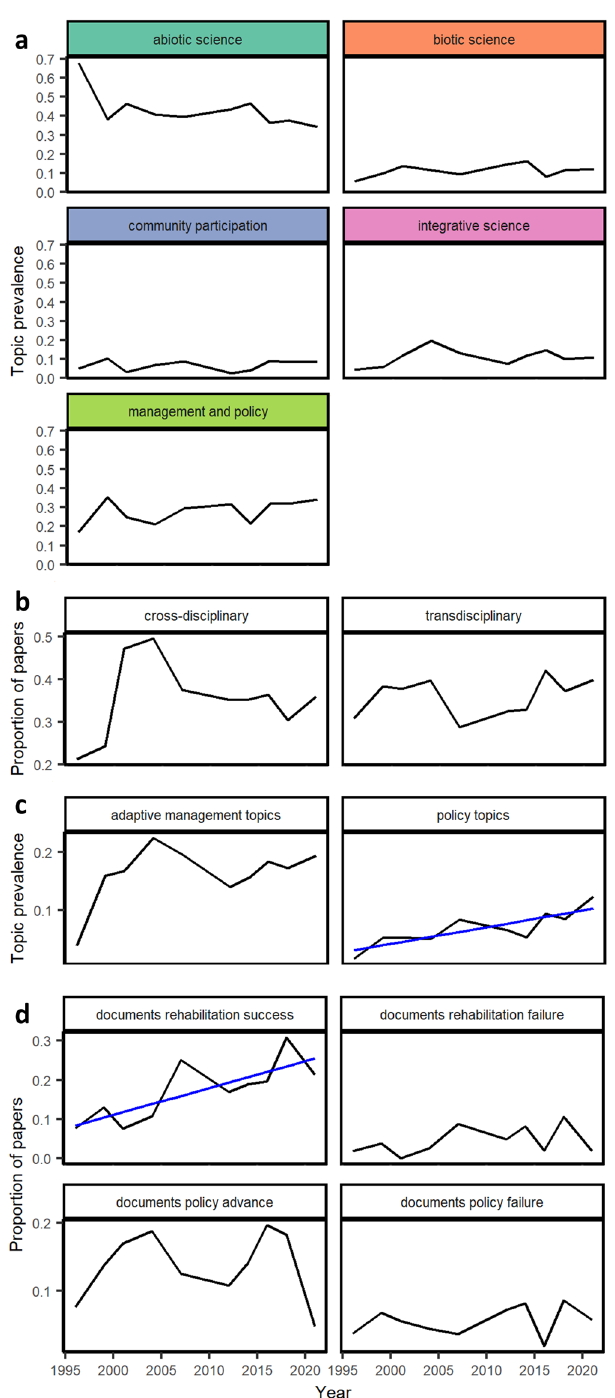
Fig. 5 Trends in disciplines, interdisciplinarity, policy, and adaptive management topics. a topic prevalence aggregated by discipline (coloured by discipline as per Fig. 4, Fig. 6); b proportion cross-disciplinary and transdisciplinary papers; c prevalence of topics on adaptive management and policy; d proportion of papers which document rehabilitation success/ failure (as indicators of adaptive management), and policy advances/ failures. a – c are derived from topic modelling results while d is derived from structured review. Black lines show data, solid blue lines indicate trends with p < 0.01 (considered here to be signi fi cant trends). There were no trends with 0.01 < p <